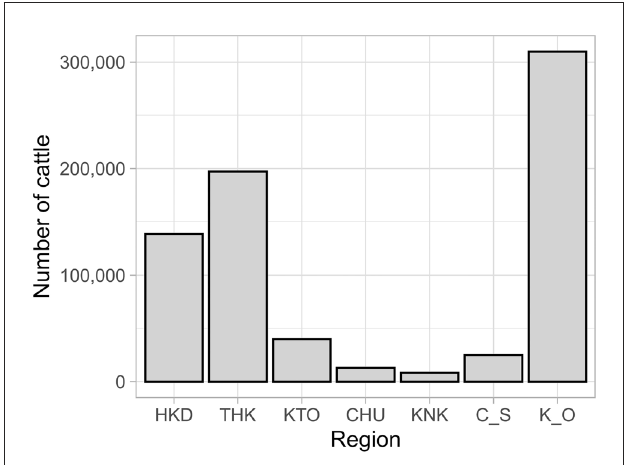
FIGURE2 Number of intra-regional movements of beef cows by region in Japan from FY2012 to FY2017. HKD, Hokkaido; THK, Tohoku; KTO, Kanto; CHU, Chubu; KNK, Kinki; C_S, Chugoku/Shikoku; K_O, Kyushu/Okinawa.